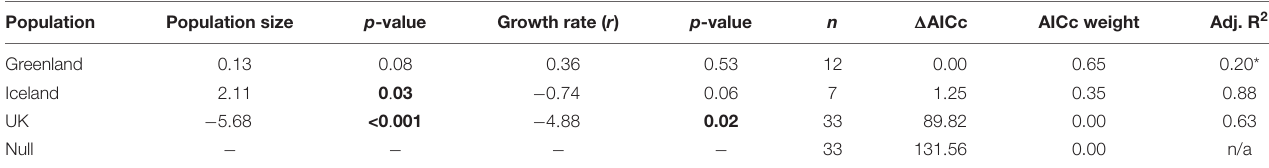
TABLE 1 | Parameter estimates for univariate generalized linear models (GLMs) of the relationship between trend estimates of vagrant LBBG occurrence in North America from CBC data and indices of annual breeding population size and growth rate ( r ) of the breeding population in the UK, Iceland, and Greenland. Population Population size p -value Growth rate ( r ) p -value n (cid:49) AICc AICc weight Adj. R 2 Greenland 0 . 13 0 . 08 0 . 36 0.53 12 0 . 00 0.65 0.20* Iceland 2 . 11 0 . 03 − 0 . 74 Null − − − − 33 131 . 56 0.00 n/a